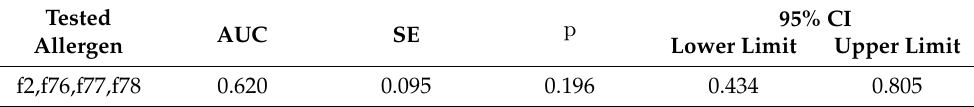
Table 2. Characteristics of the ROC curve—multiple analysis, cow milk as a combined variable. Tested